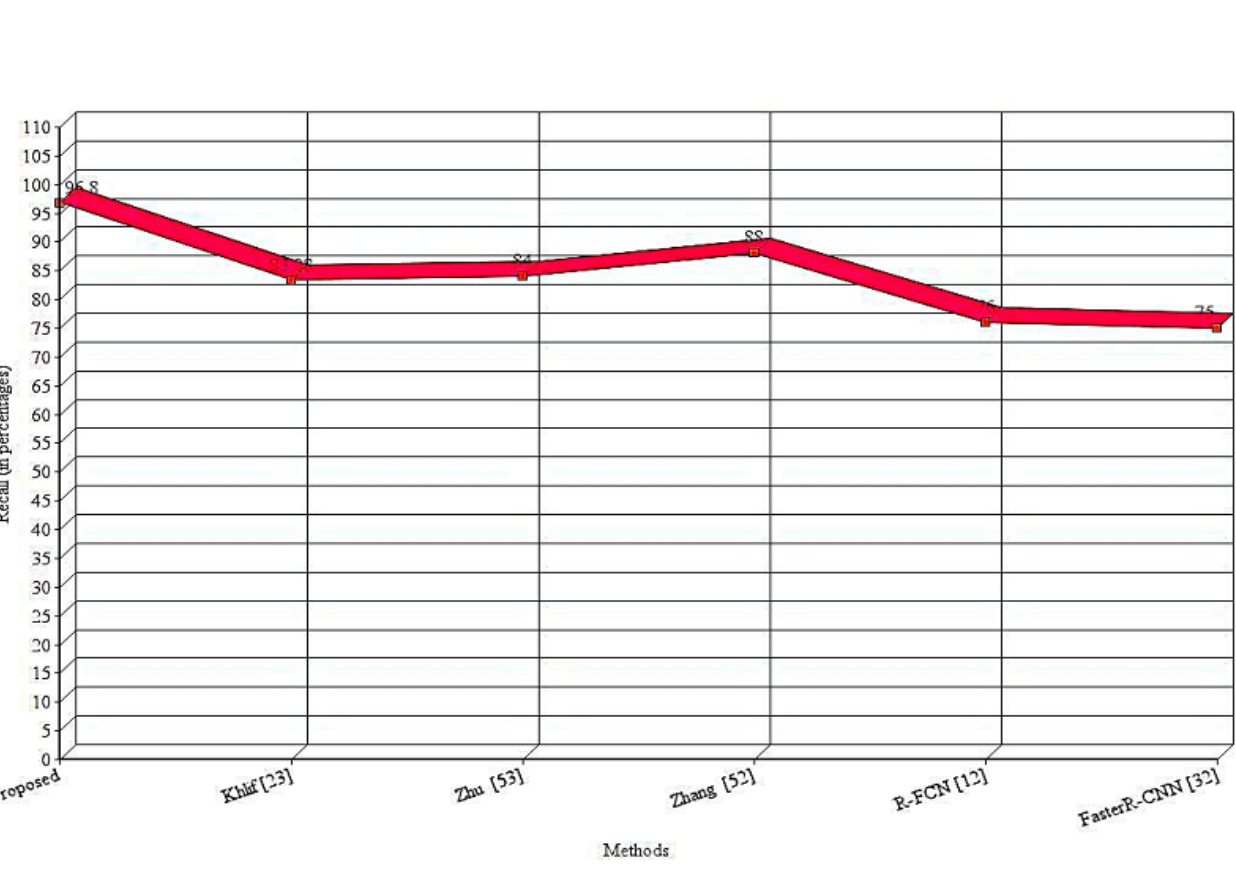
Figure 10. Comparison of recall for proposed and existing methods